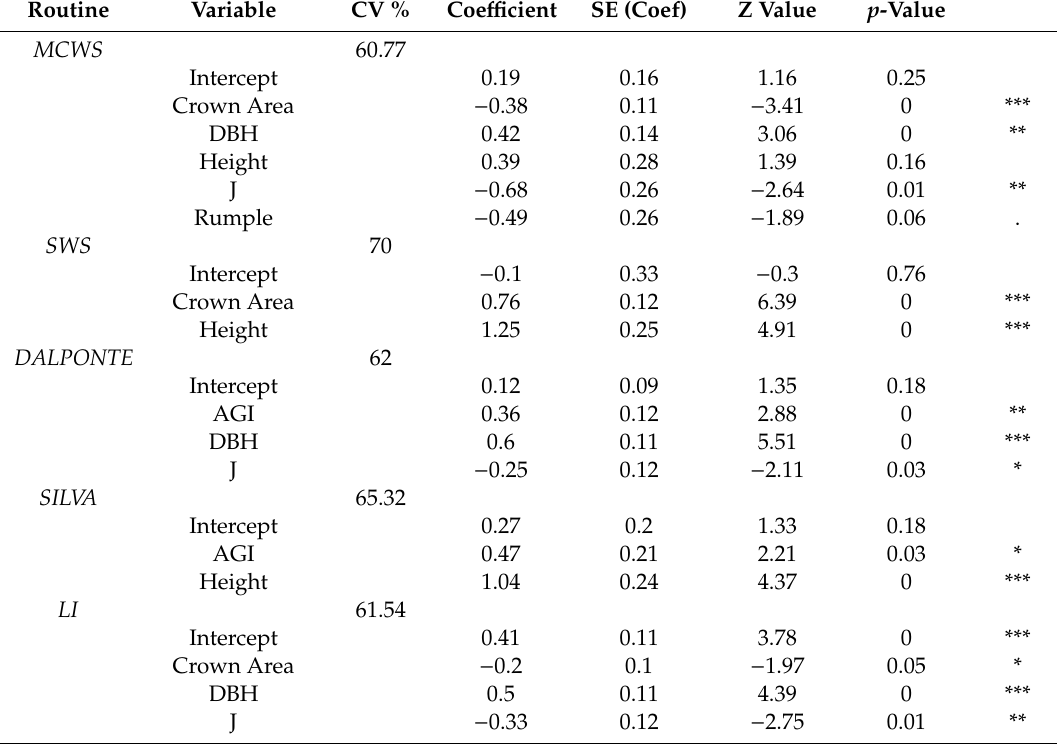
Table 3. Results of the logit models assessing the important tree- and plot-level variables influencing the odds of successful individual tree crown delineation. All variables were standardized prior to analyses. The table includes the 10-fold cross-validation (CV %) model accuracy estimates, coe ffi cients of variables in the models and the corresponding standard error (SE) (* p < 0.05, ** p < 0.01, *** p <